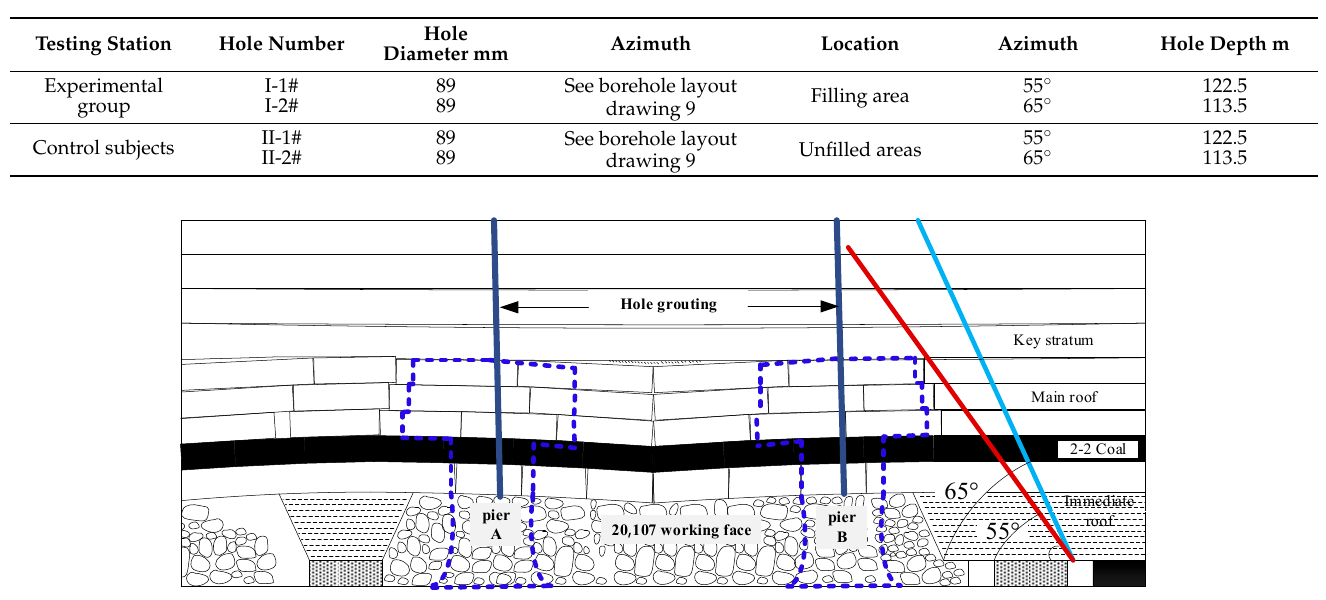
Figure 9. Profile of survey point arrangement.